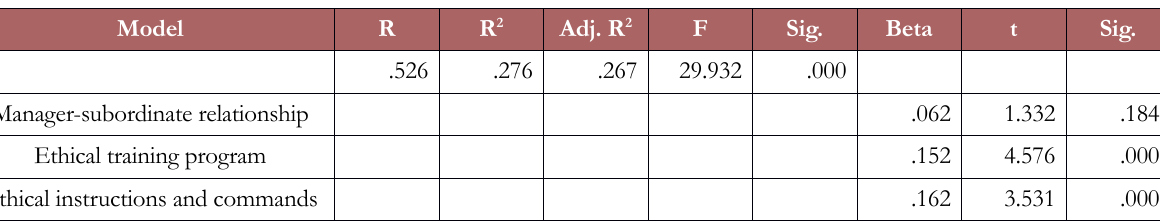
Table 7. Multiple simultaneous regression analysis for dimensions of ethical factors- implementation of 5S and